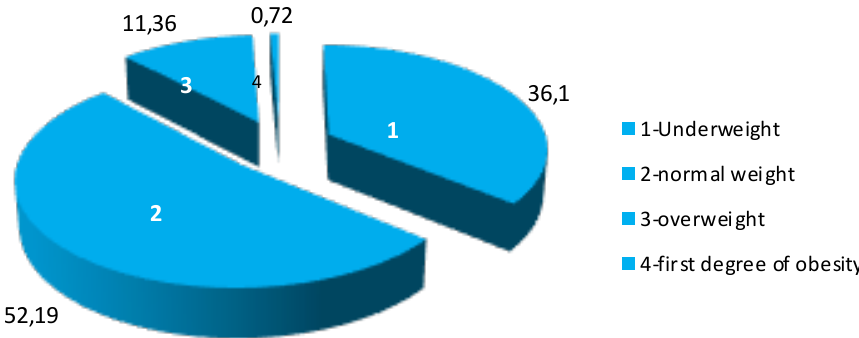
Fig. 1. Distribution of females according to BMI (in % to quantity of examined